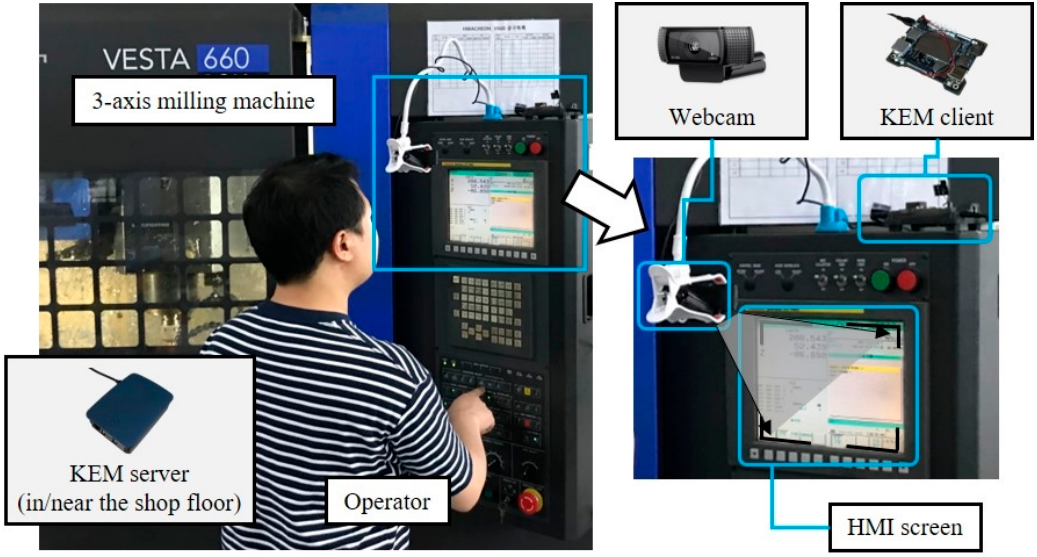
Figure 8. Configuration of the prototype evaluation.